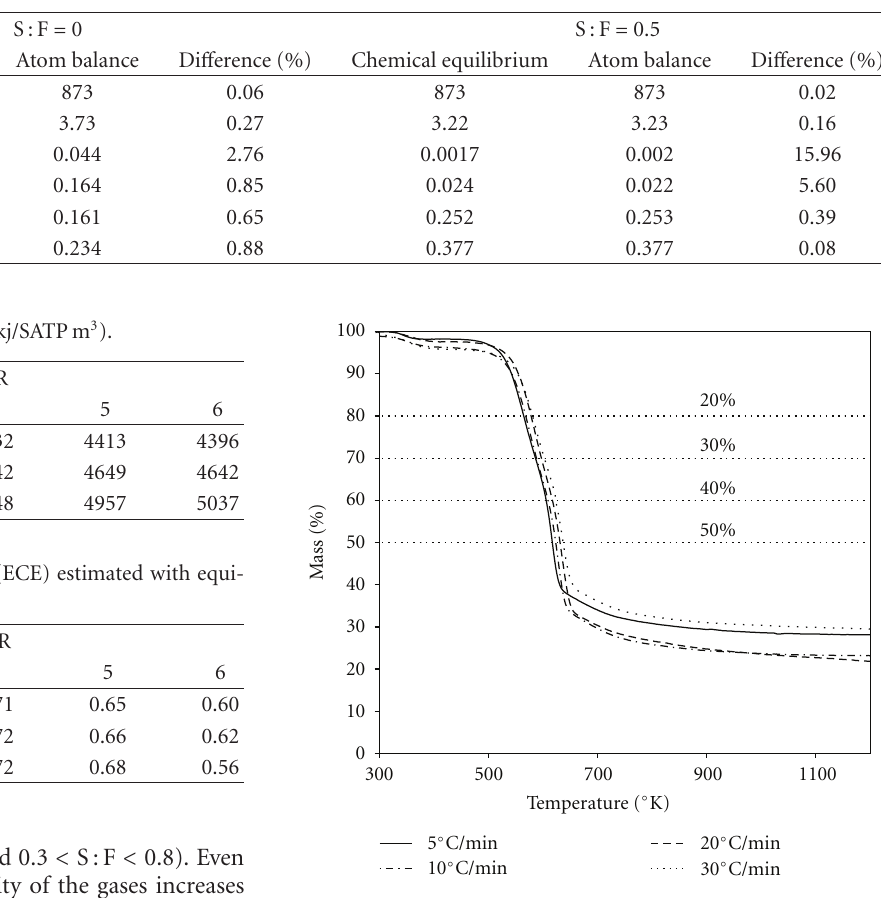
Table 5: Comparison of results on gas composition (mole fraction on a dry basis) obtained by atom and equilibrium model, adopted from [14].